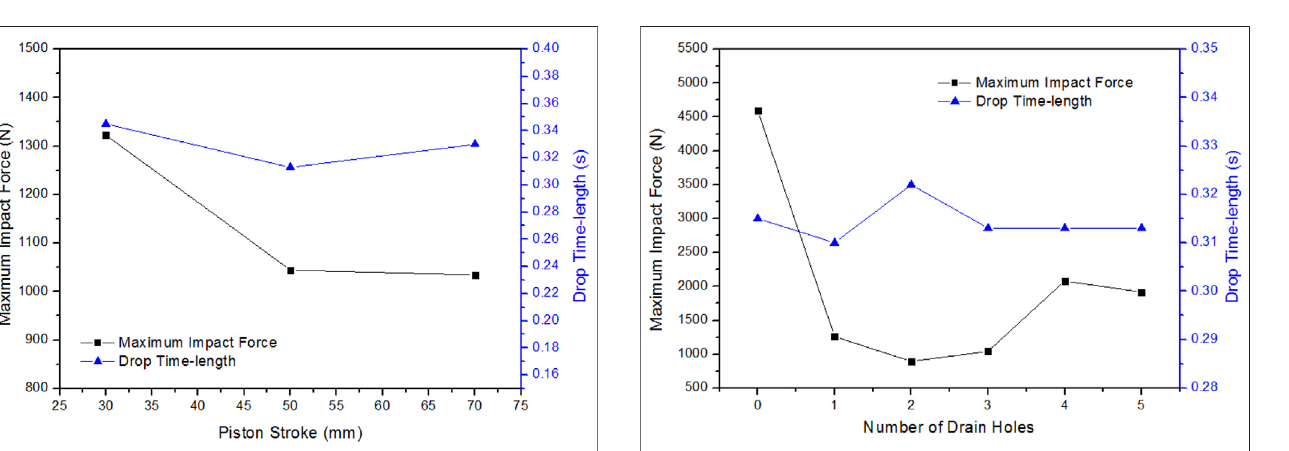
FIGURE 8 | The effects of HolesNumber on the maximum impact force and the drop time-length.